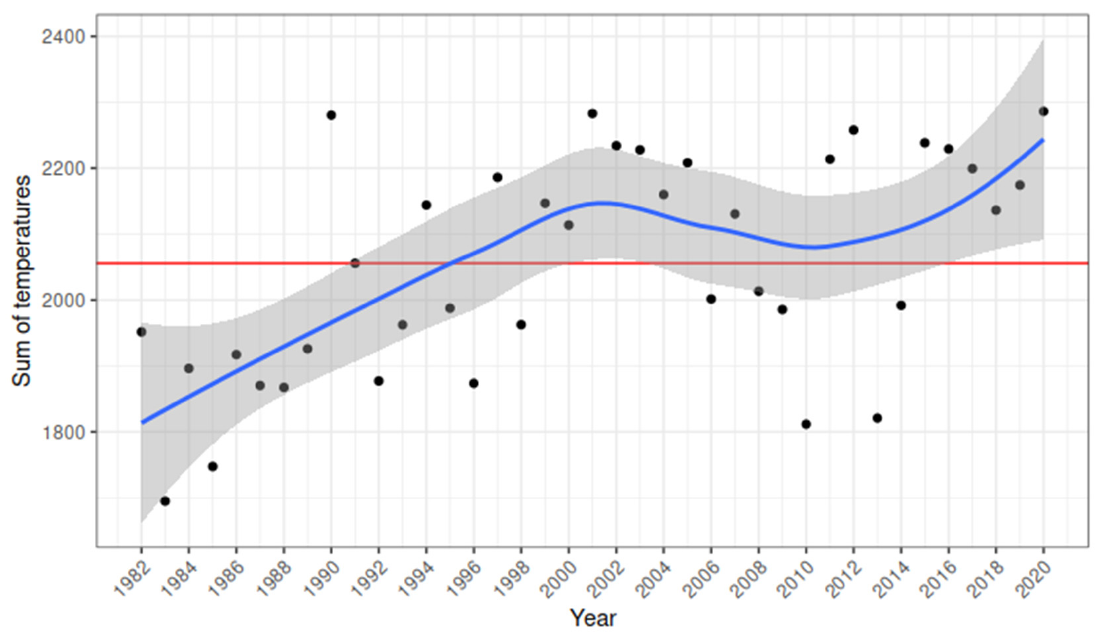
Figure 3. Relationship between the sum of temperatures above five degrees (t > +5 °C) and the year of observation.